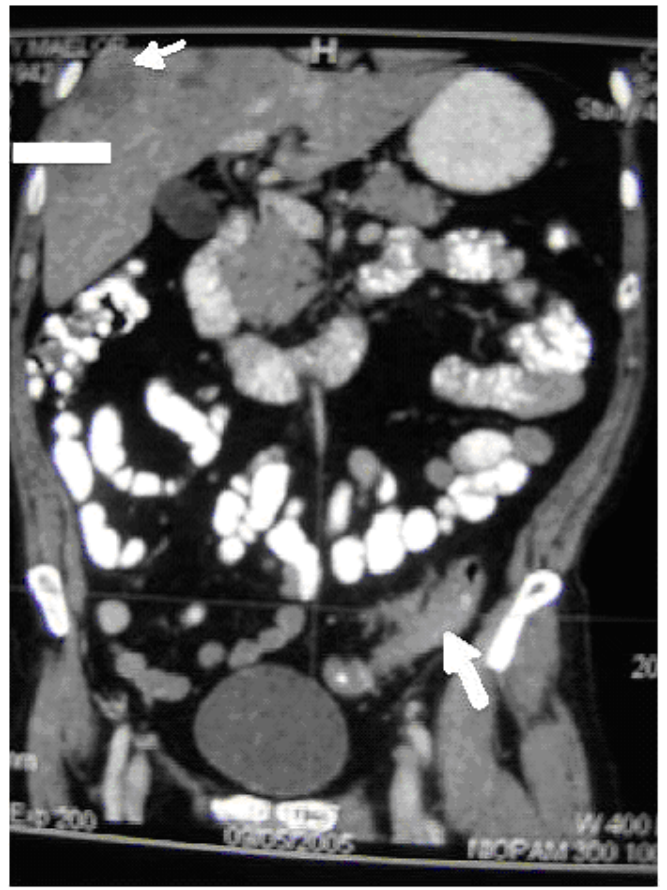
FIGURE 3. CT abdomen showing thickened, descending colon with extensive liver metastasis (both shown in